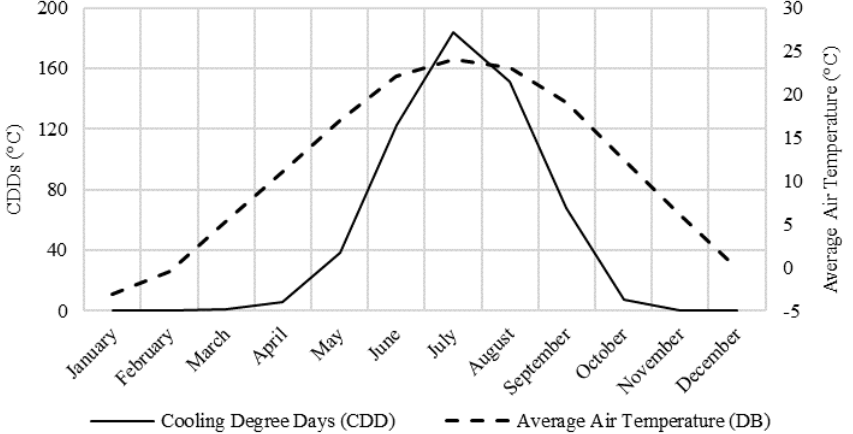
Figure 1. The Cooling Degree Days (CDDs) and average dry air temperature in Indiana (Data retrieved from [33]). Table 1. The parameters for the base case.